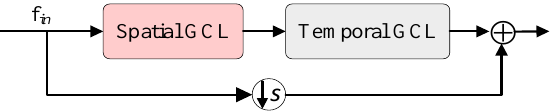
Figure 4. The structure of the traditional basic block.